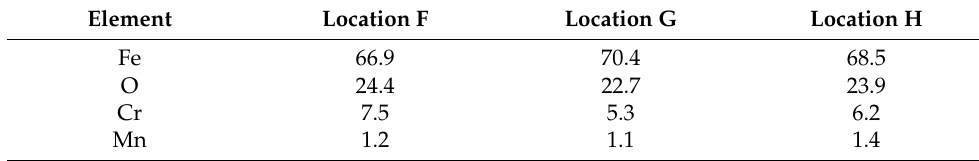
Table 9. Quantitative EDX analysis, sample P91 oxidized for 3000 h at 650 ◦ C (in wt.%).